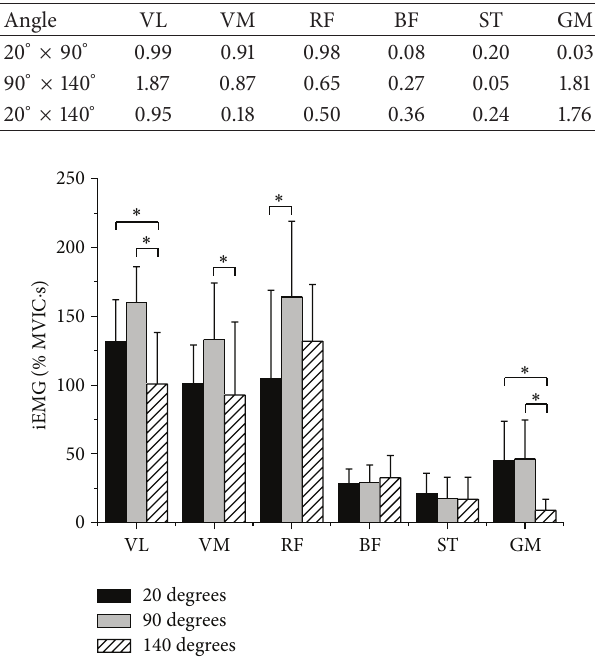
Figure 1: Mean and standard deviation of iEMG in three different knee joint-angle positions. ∗ Significant differences, 𝑃 < 0.05